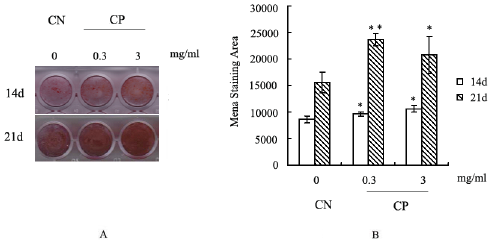
Figure 5. Influence of bovine CP compounds on mineralization in MC3T3-E1 cells. The calcium deposits in the mineralized matrix were analyzed by alizarin red staining. MC3T3-E1 cells induced with osteogenic medium after treatment with 0.3–3 mg/mL CP or no treatment (CN) for 14 or 21 days are shown. Data are expressed as means 6 standard deviation ( n =4). * p , 0.05, Significant difference from CN. CP: bovine collagen peptides compounds; CN: control.